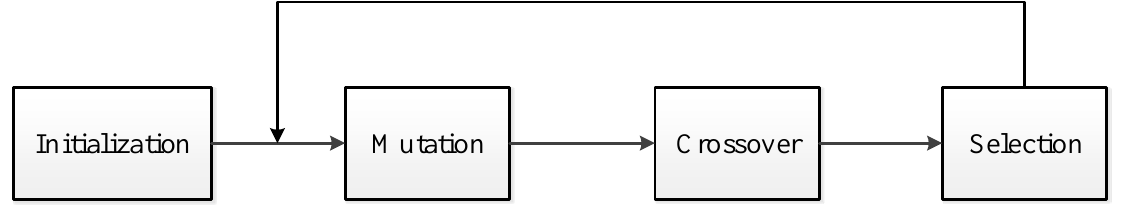
Figure 8. Schematic diagram of differential evolution (DE) algorithm .